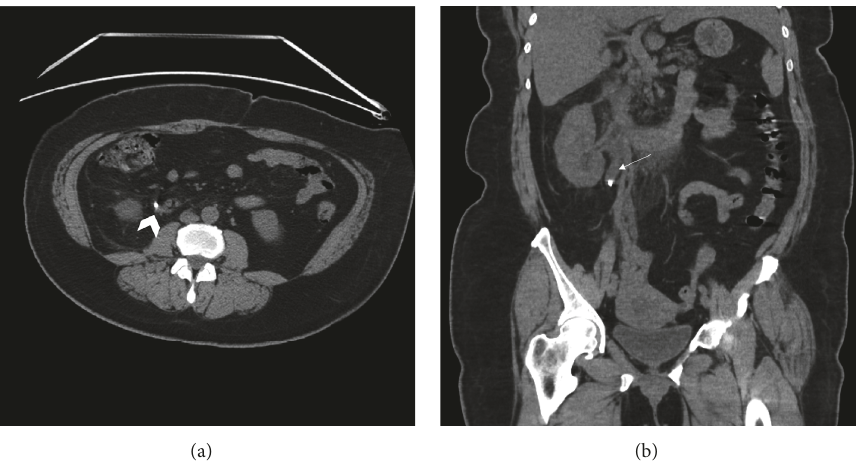
Figure 3:Axial (a) and coronal(b) CT scans of the abdomen and pelvis without contrastrevealed an 8 mm rightobstructiveproximal ureteral stone ((a) arrowhead) causing hydroureter and hydronephrosis ((b)